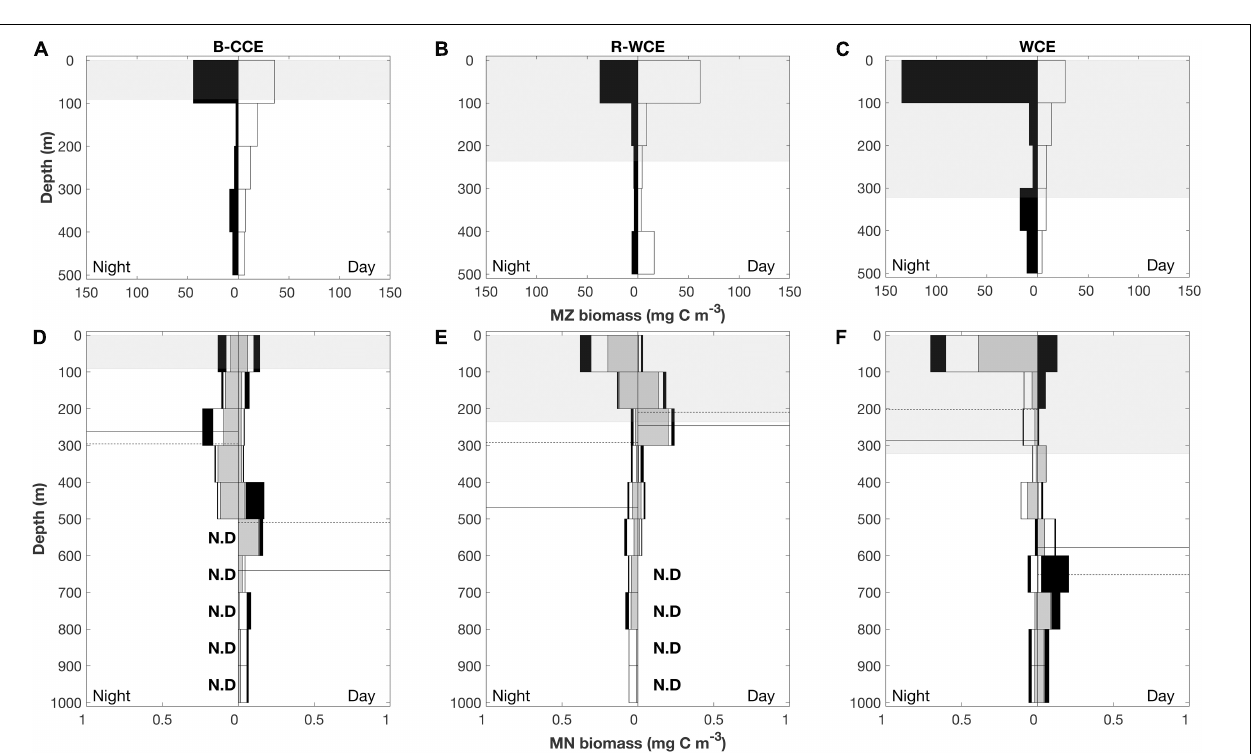
FIGURE 4 | Depth profile of mesozooplankton at the (A) F-CCE Center and (B) F-CCE Edge. Nighttime profiles are left-hand panes, and daytime profiles are right-hand panes. Shaded gray areas represent mean ( ± SD) mixed layer depth.